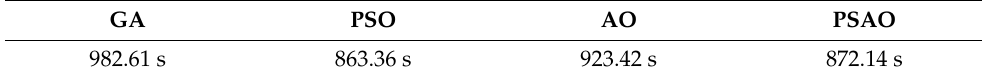
Table 5. Solving